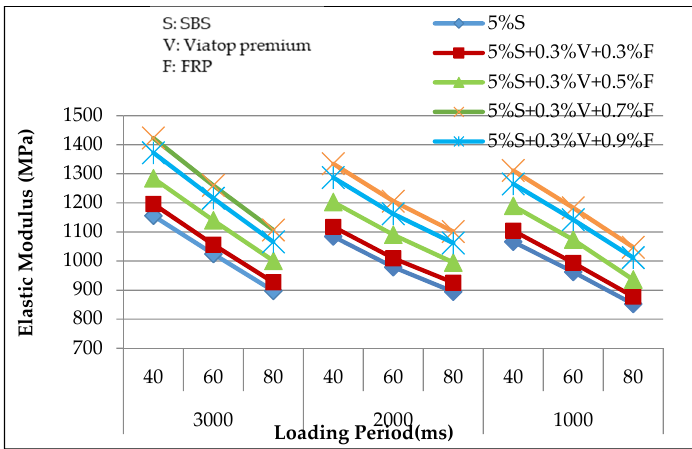
Figure 8. The result of Resilient Modulus Test at 25 °C.